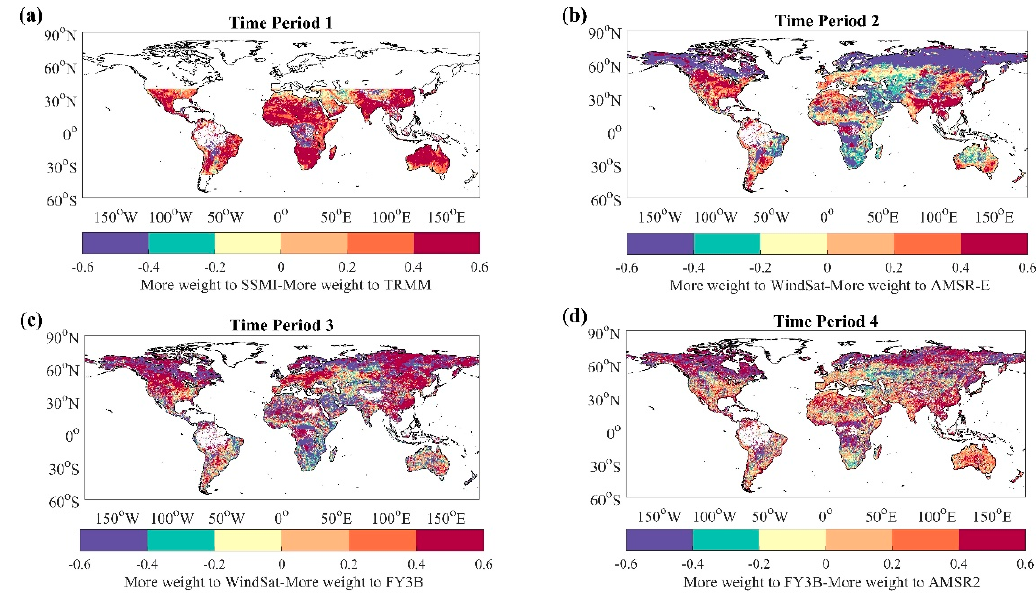
Figure 3. Relative contributions of the individual satellite observations in the merging scheme for ( a ) time period 1, ( b ) time period 2, ( c ) time period 3 and ( d ) time period 4. Colors show where more weight in each period is from either of the satellite observations.